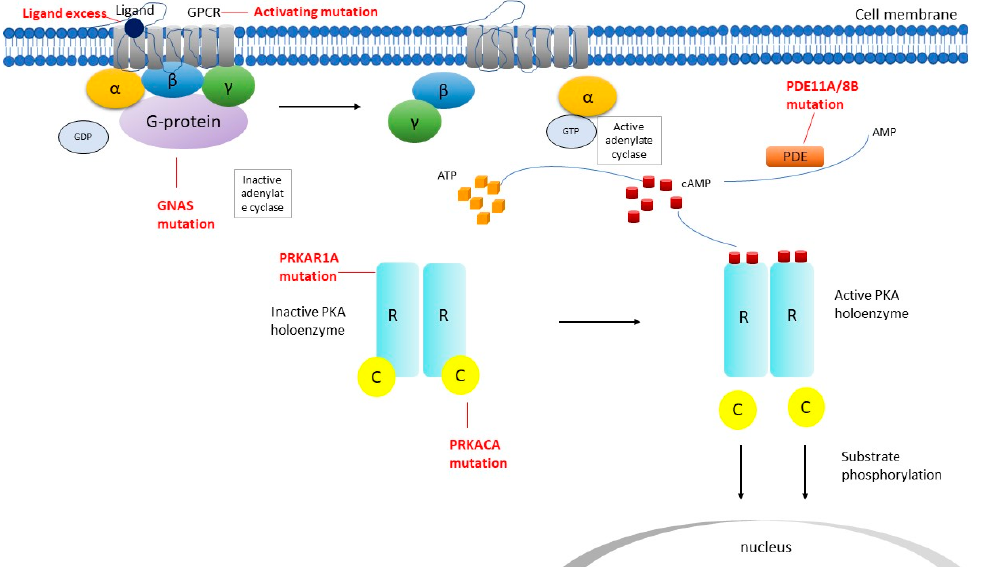
Figure 2. Schematic representation of cyclic adenosine monophosphate (cAMP) signaling pathway in primary adrenal neoplasms. C catalytic subunit of PKA, GDP guanosine diphosphate, GNAS gene coding for the stimulatory subunit α of the G-protein (Gs α ), GPCR G-protein coupled receptor, GTP guanosine triphosphate, PDE phosphodiesterase, PDE11A/8B phosphodiesterase 11A and 8B respectively, PKA protein kinase, R regulatory subunit of PKA, α , β , γ subunits, PRKACA protein kinase cAMP-dependent catalytic, alpha PRKAR1A protein kinase cAMP-dependent regulatory type I α